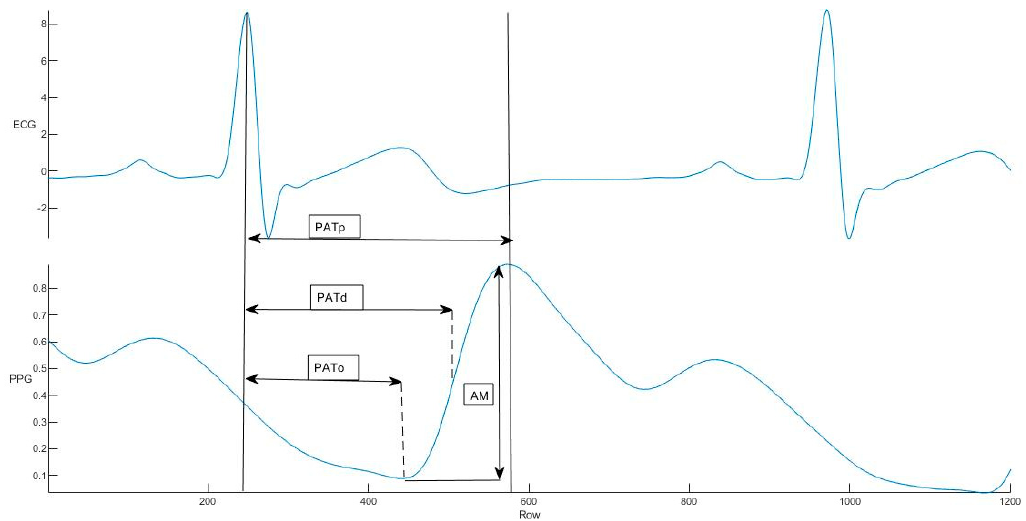
Figure 2. ECG and PPG signals. Pulse arrival time (PAT) for different points of the PPG signal recorded in this study.